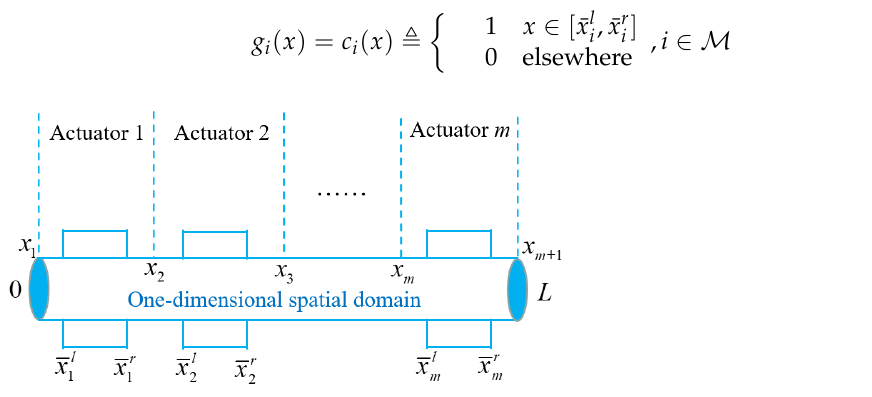
Figure 1. Abstract structure diagram of the distributions of actuators in one-dimensional spatial